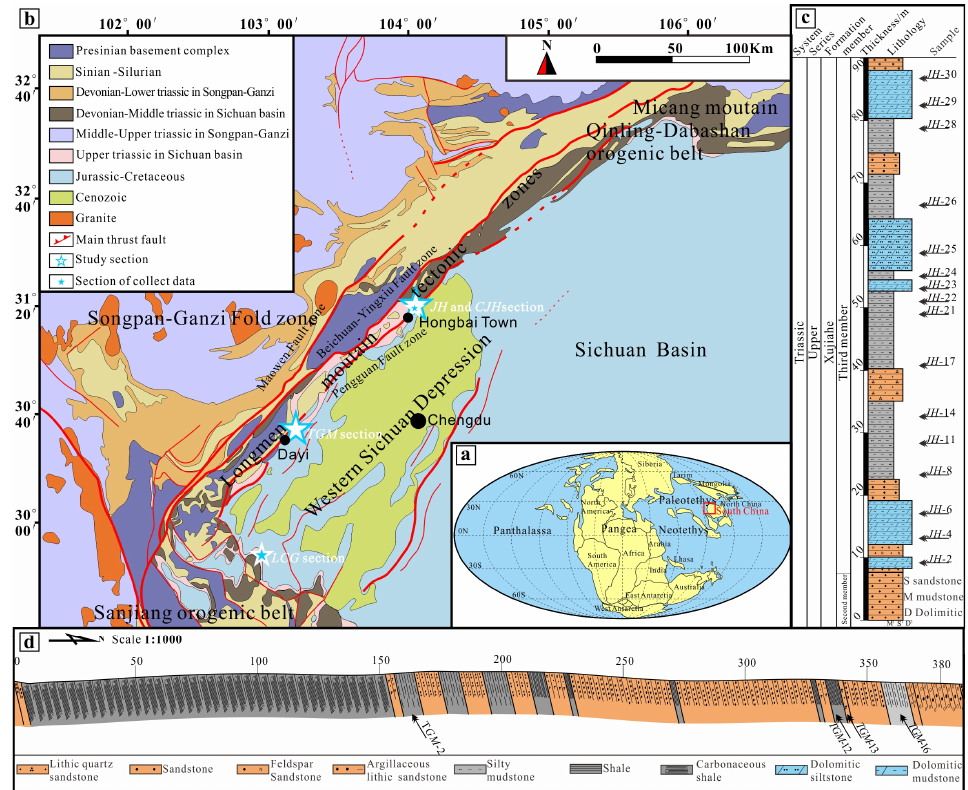
Figure 1. Geological sketch of the Western Sichuan Depression and histogram of the JH section and TGM section. ( a ) Paleogeographic Map of the Late Triassic (According to [36] revised); ( b ) Geological map of the Western Sichuan Depression (According to [31] revised); ( c ) JH section Histogram; ( d ) TGM section Histogram.